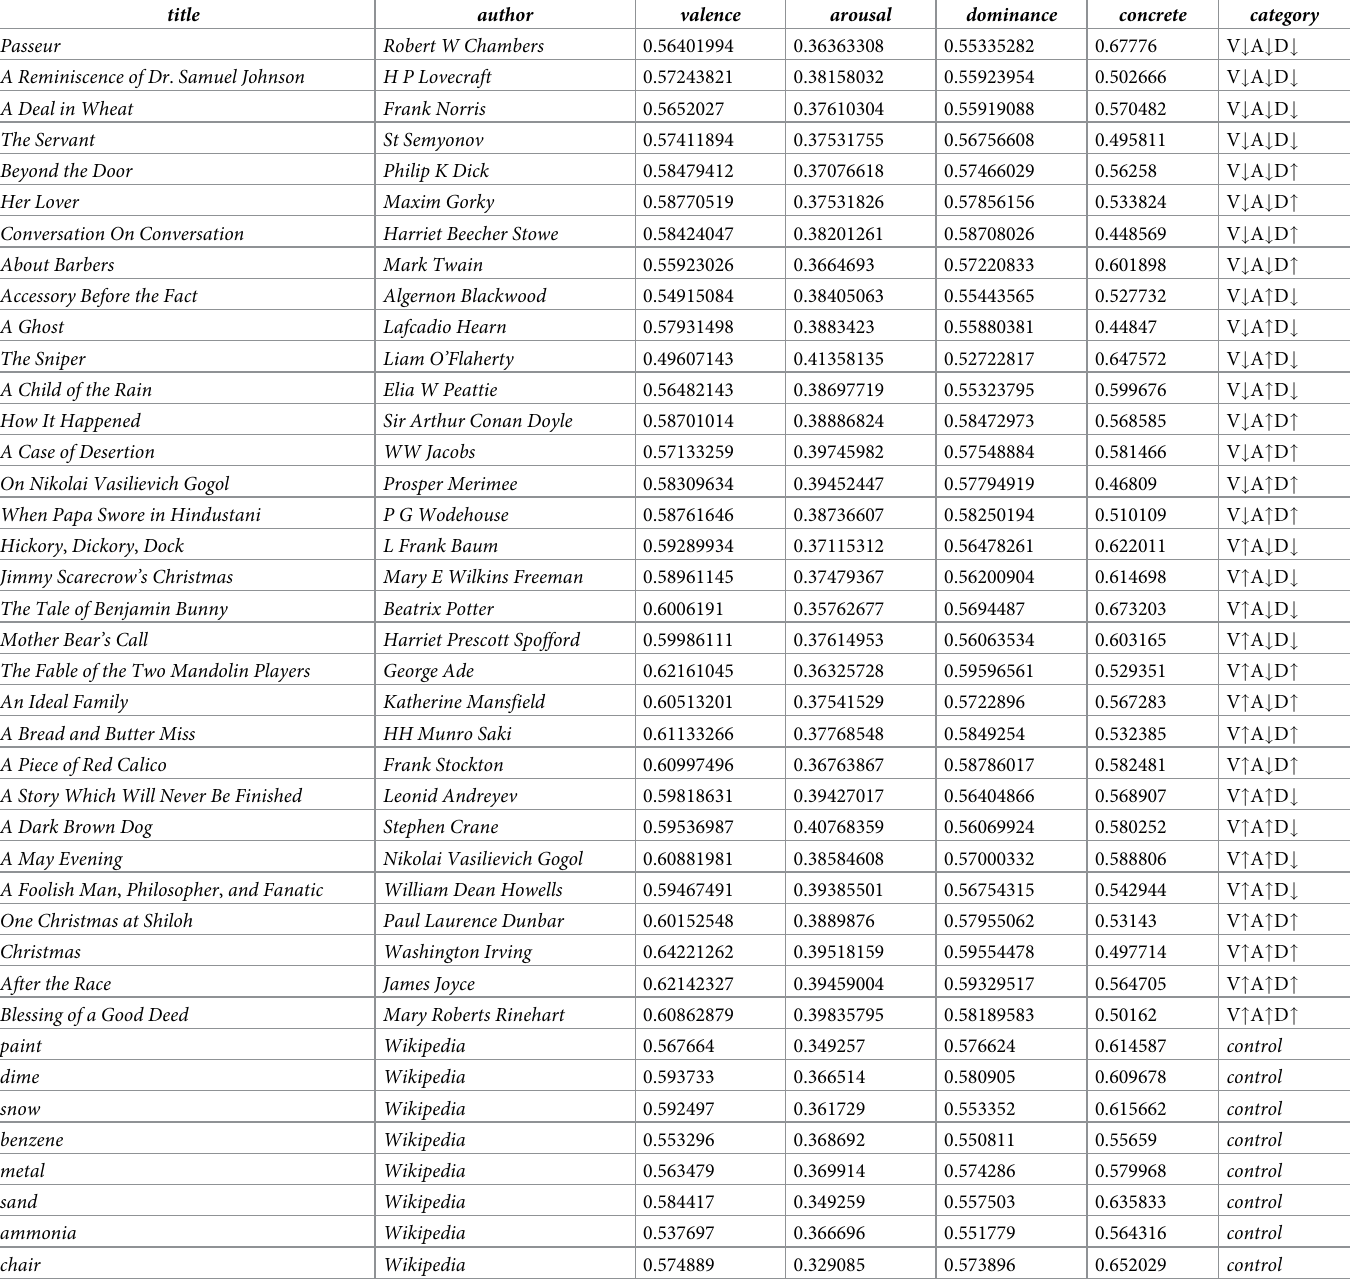
Table 3. Texts with VAD + C values and category designation in Study